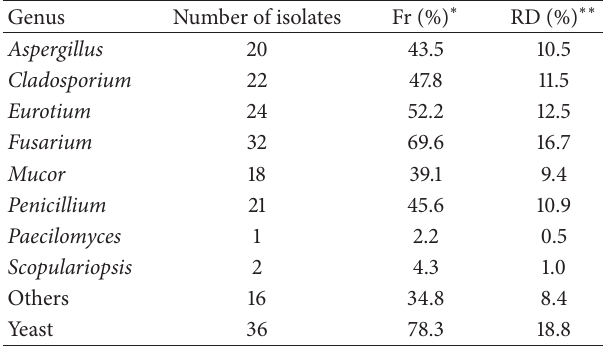
Table 2: Fungal genus present in poultry feed